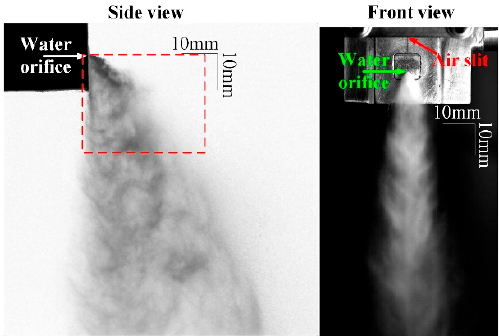
Figure 4. The typical side and front views of the spray far field [20].